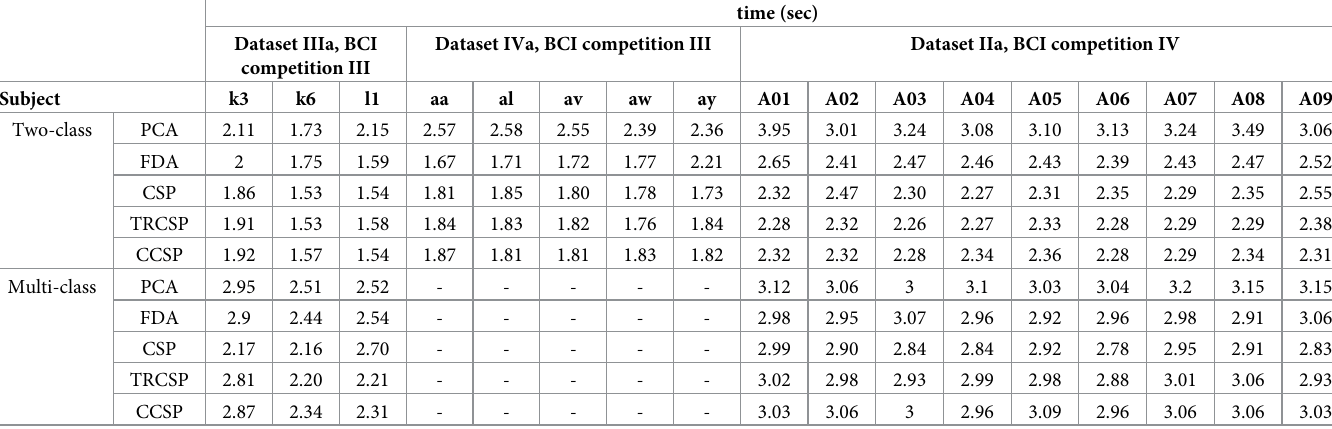
Table 4. Running time for two-class and multi-class problems.